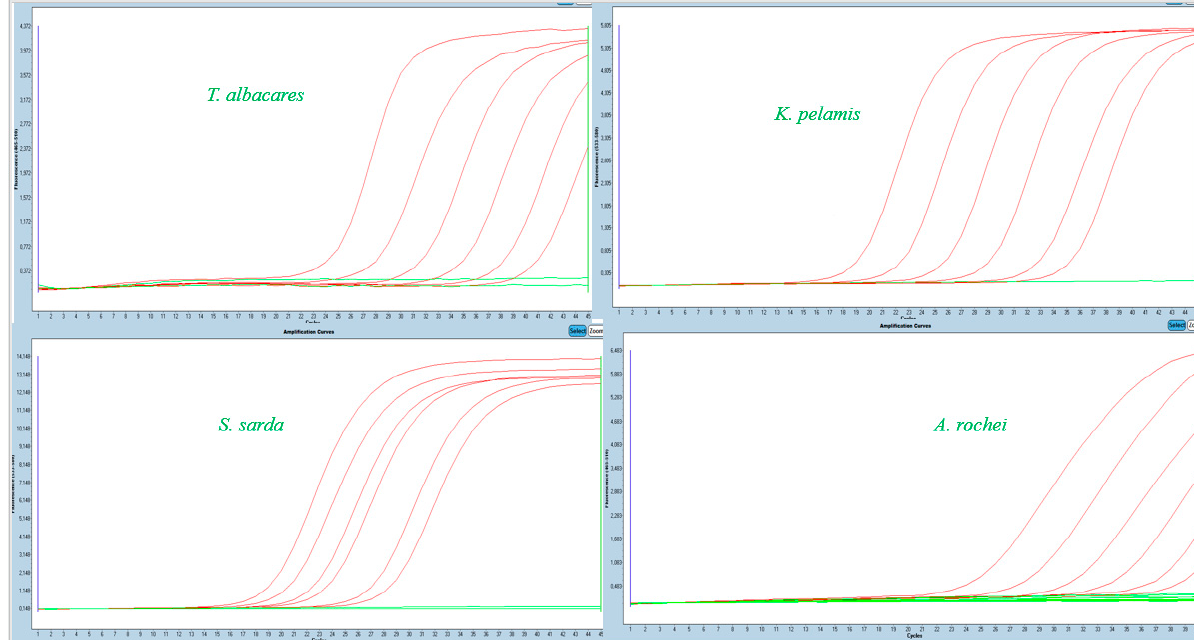
Figure 2. Serial dilution of DNA from different species (10 ng/ μ L; 1ng/ μ L; 100 pg/ μ L; 10 pg/ μ L; 1pg/ μ L; 100 fg/ μ L; 10 fg/ μ L)—curves from the left according to the indicated dilution.